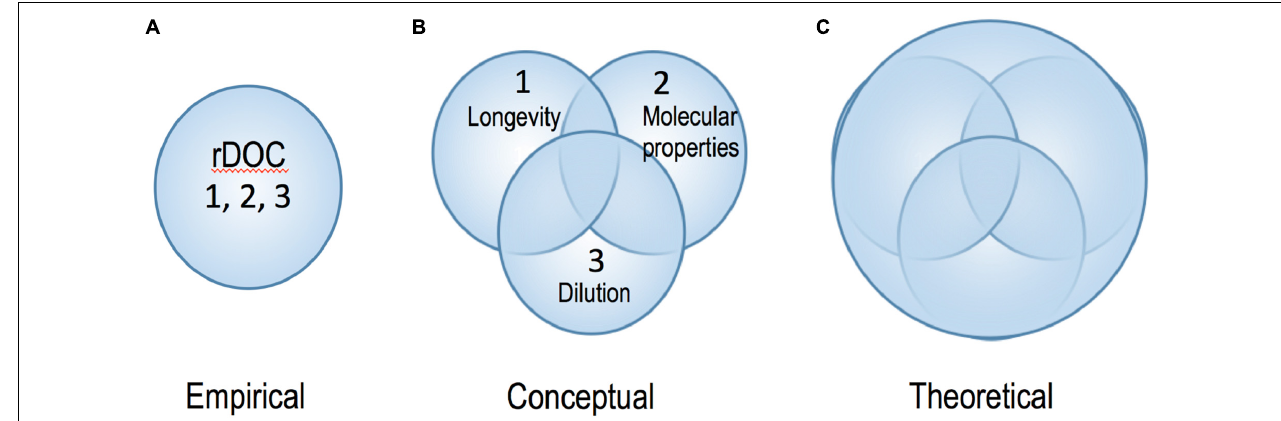
FIGURE 2 | Diagram showing different levels of relationship of three currently employed characteristics, properties and definitions (i.e., 1, 2, and 3) of “refractory” DOC (see text for details): (A) the case in which the three definitions are complementary, (B) the case where the three definitions are sometimes complementary for some compounds under specific environmental conditions. Part (A) is empirical, part (B) is conceptual. The ultimate goal of our research is represented by the integrative part (C) , related to biochemical theory for individual